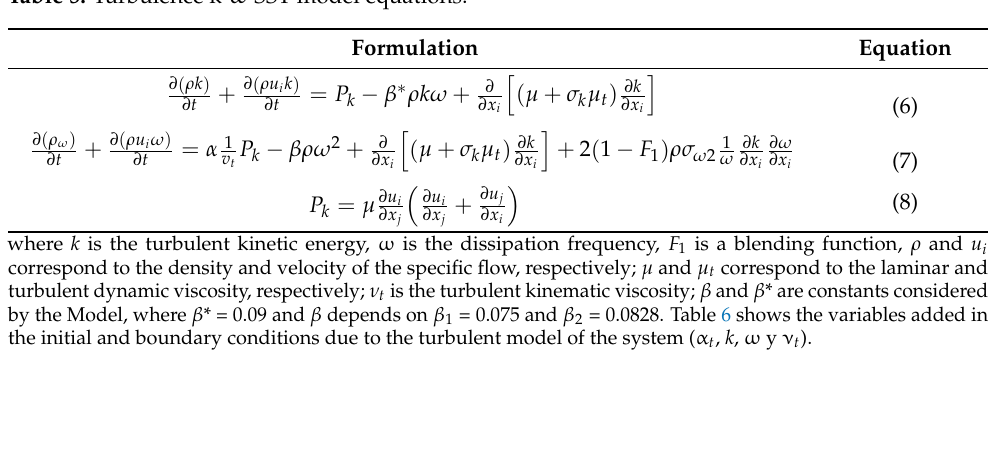
Table 4. Boundary conditions for the variables of the turbulent model.